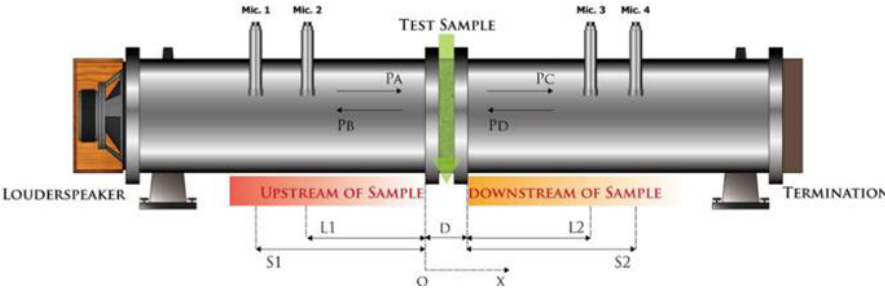
Figure 4. Content of sound transmission loss measurement.